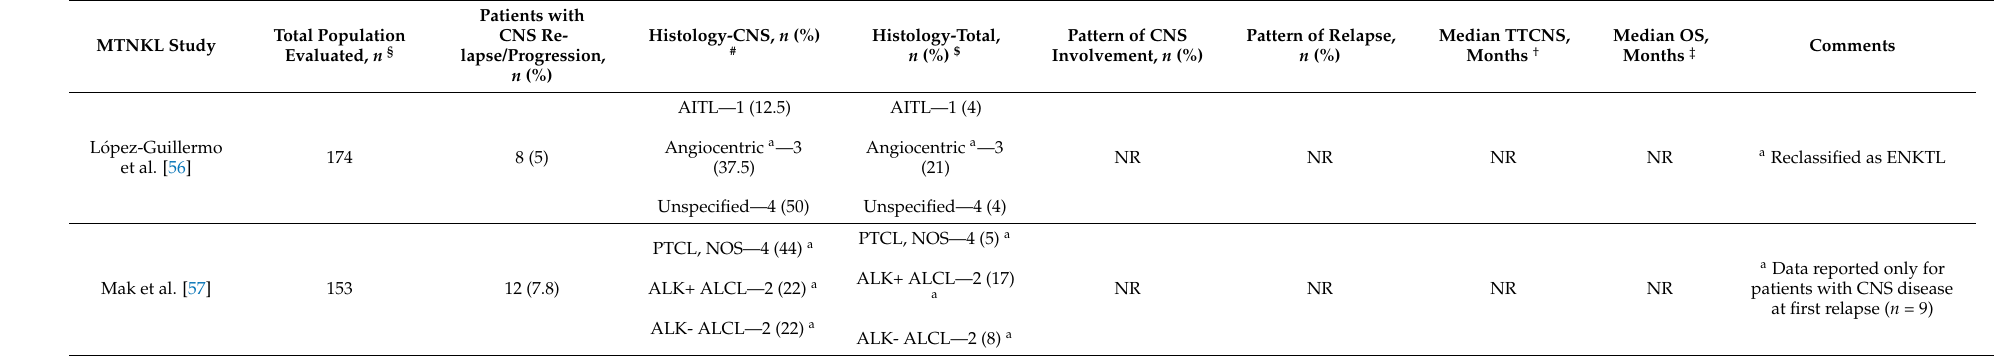
Table 2. Summary of MTNKL-specific studies describing incidence, patterns, and outcomes of CNS relapse in patients with